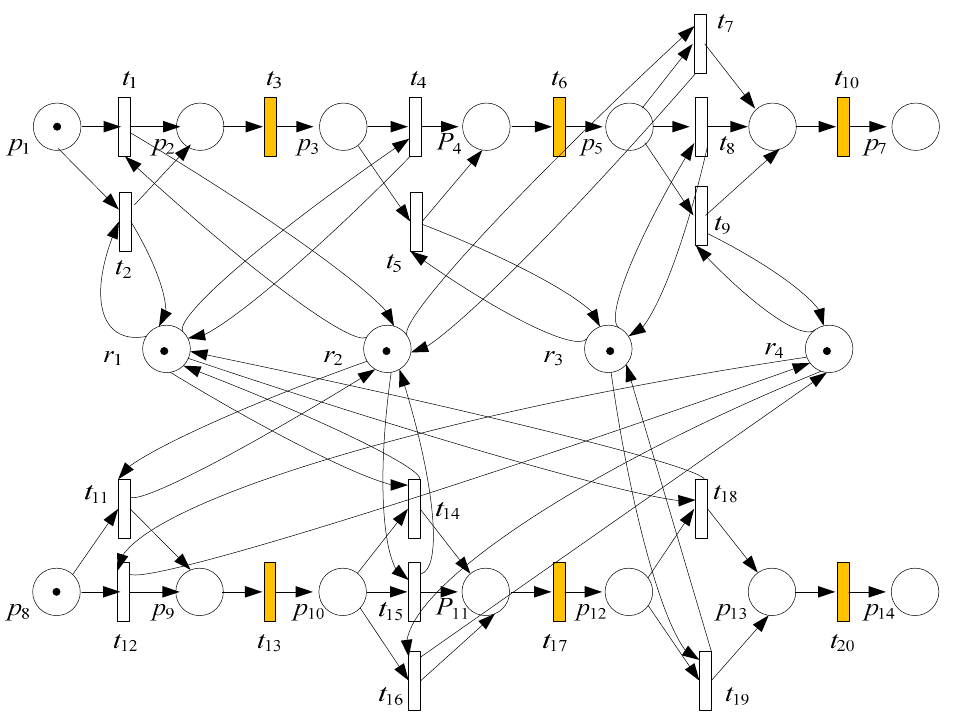
Figure 4. PN model for a FJSP ‐ IT example.